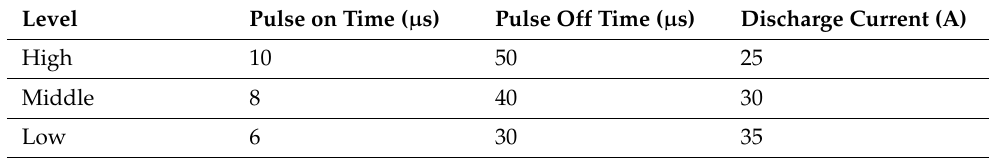
Table 2. Ranges of setup